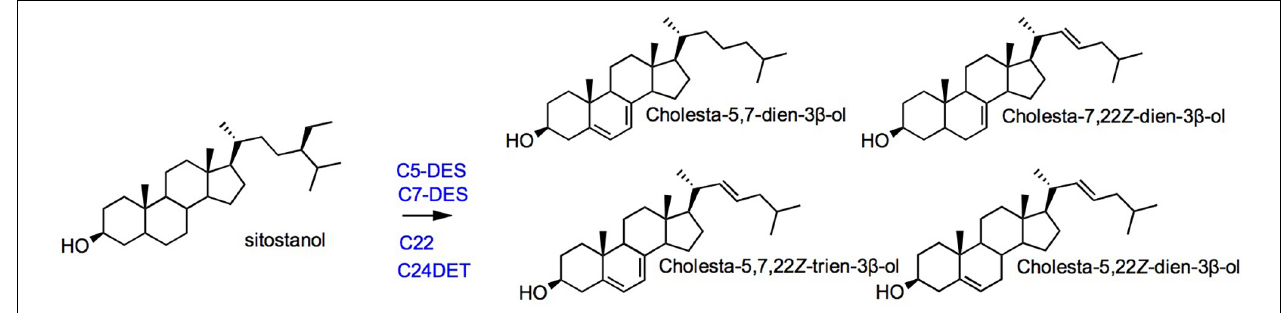
FIGURE 6 | Sterol metabolization reactions in the ciliate Tetrahymena . The conversion of sitostanol is shown [adapted from Najle et al. (2013)]. C5-DES, sterol-5(6)-desaturase; C7-DES, sterol-7-desaturase; C22-DES, sterol-22-desaturase; and C24DET, sterol-24-de-ethylase enzyme abbreviations from Najle et al.